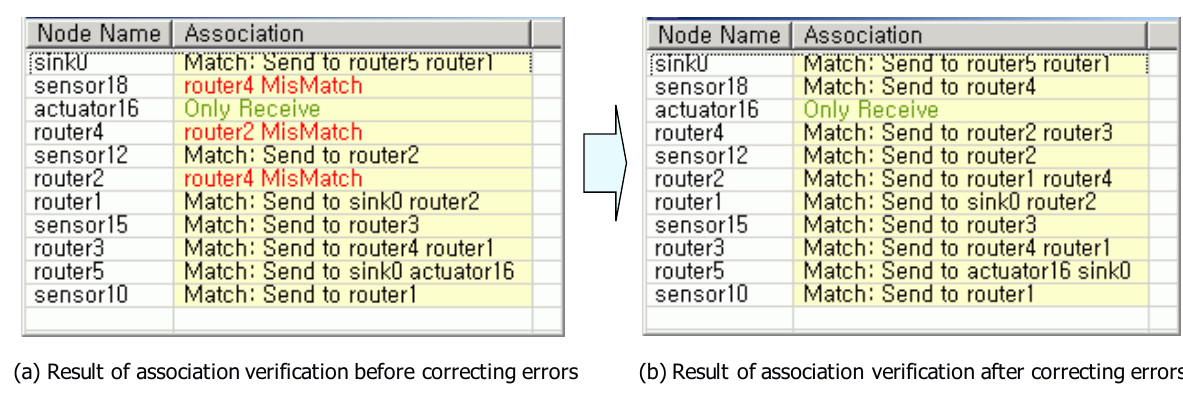
Figure 8. The result of association